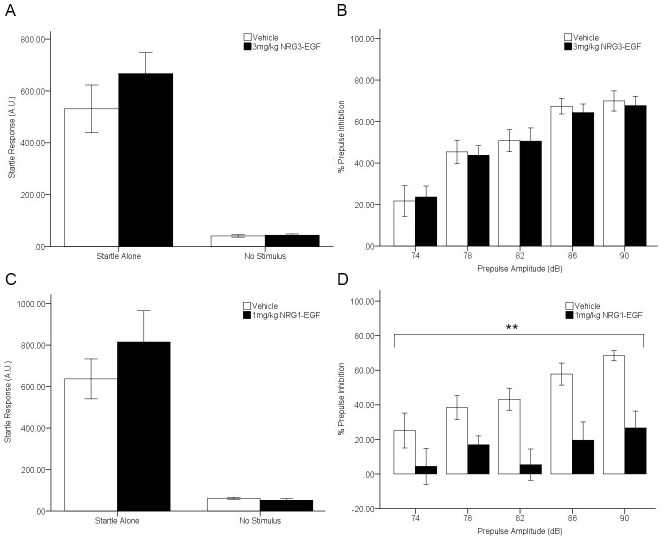
Neonatal overexposure to NRG1 but not NRG3 impairs sensorimotor gating in adulthood.The effect of daily treatment from PND 2–10 with 3 mg/kg NRG3-EGF (A, B) or 1 mg/kg NRG1-EGF (C, D) on startle responses to the presentation of no stimulus or a 120 dB stimulus (A, C) and % prepulse inhibition of the startle response to the presentation of prepulse stimuli at amplitudes of 74, 78, 82, 86 and 90 dB (B, D) in adulthood. Data represents mean ± s.e.m., n = 8–14/treatment group. **p<0.01, main effect of treatment.